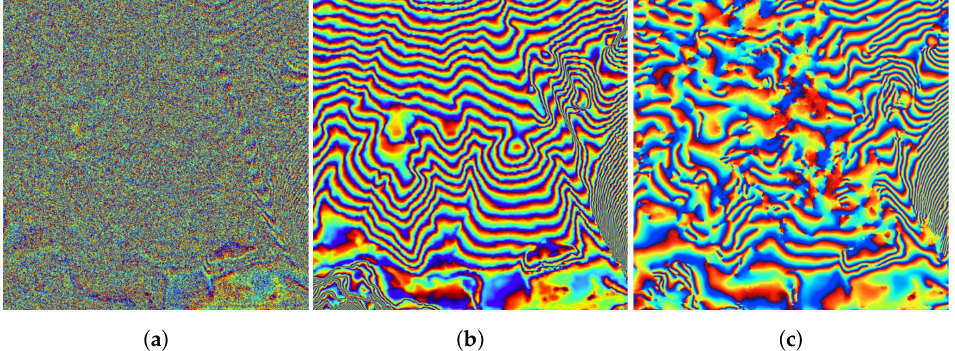
Figure 3. Example of wrong filtered signal in areas characterized by low signal-to-noise ratio (SNR) and high spatial frequency. ( a ) Noisy interferometric phase; ( b ) ground truth; ( c ) wrong filtered